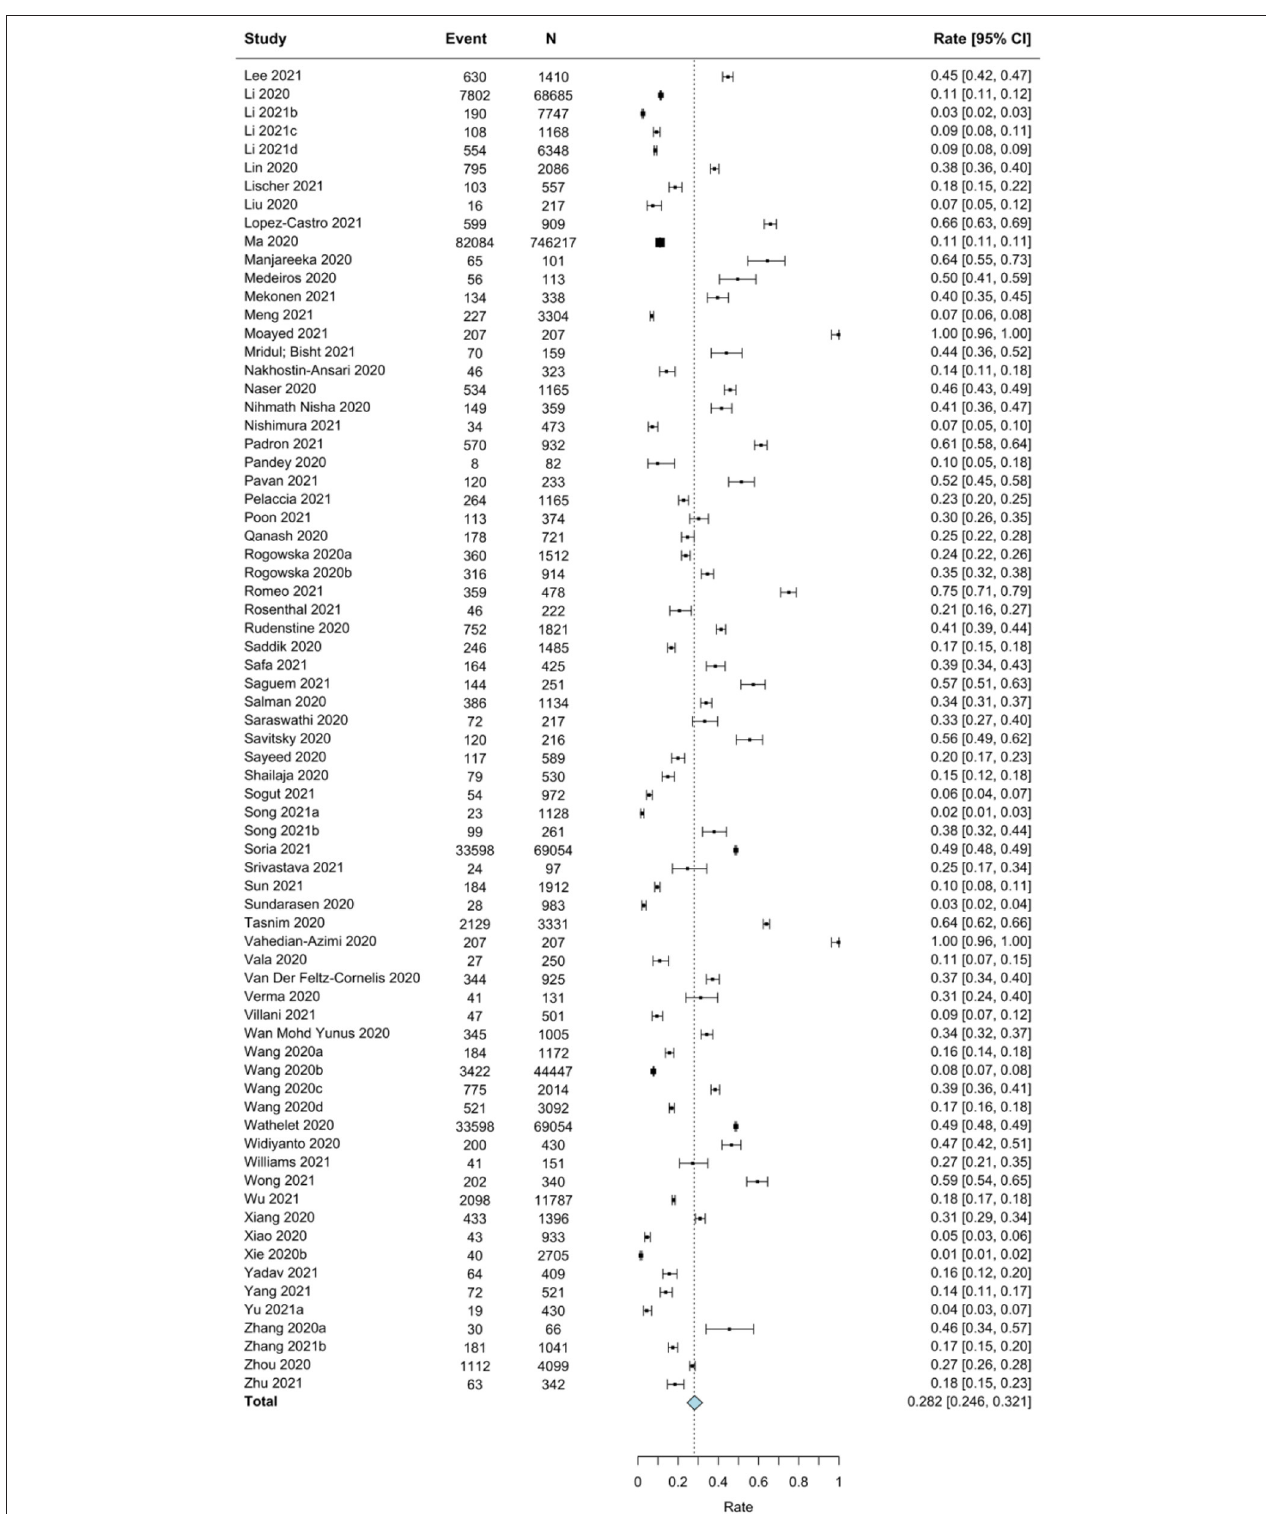
FIGURE 3 | Forest plot for the meta-analysis on prevalence rates of anxiety in students during COVID-19.